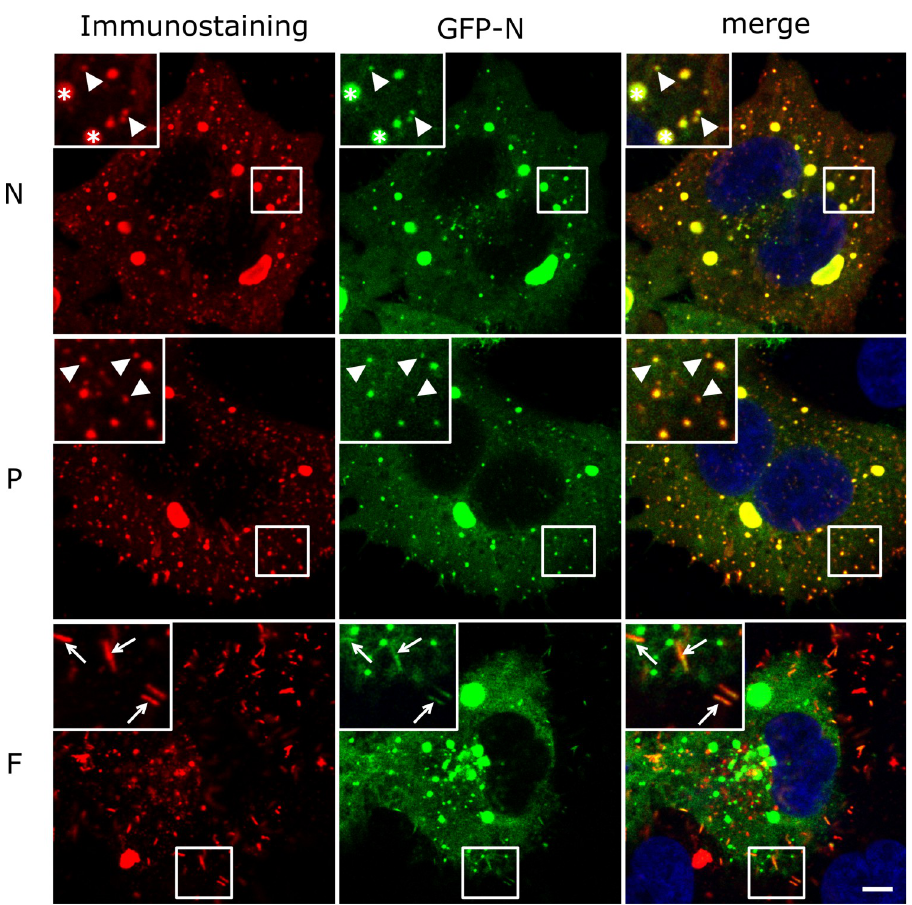
Fig 1. Localization of GFP-N and wild type N, P and F proteins in RSV-GFP-N infected cells. HEp-2 cells were infected with RSV-GFP-N. At 24h p.i. cells were stained with antibodies against N, P or F (red) and Hoechst 33342 (merge). The GFP-N protein was visualized through its spontaneous green fluorescence. IBs are indicated with a star, RNPs are indicated with white arrow heads and viral filaments are indicated with white arrows. Representative images from 2 independent experiments are shown. Images stacks (3 z-steps) were processed as maximum projections and visualized after gaussian filter fixed at 0.5. Scale bar 5 μ m.